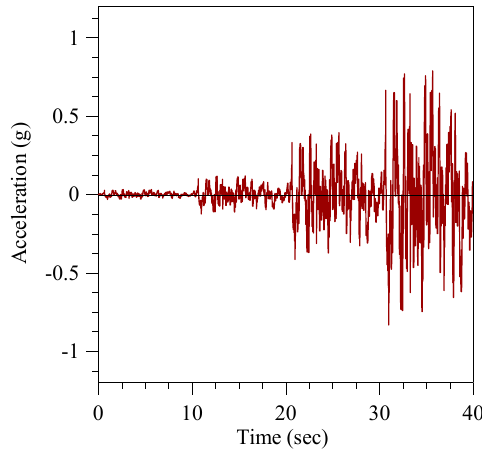
Figure 6. Loading protocol: acceleration record.